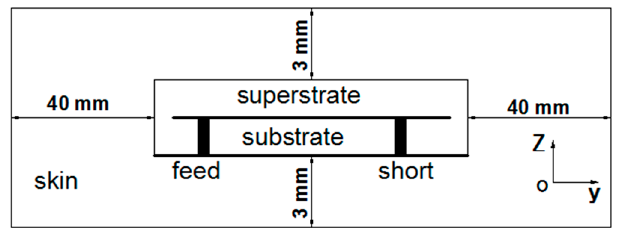
Figure 2. Side view of simulation model for the proposed implantable antenna.